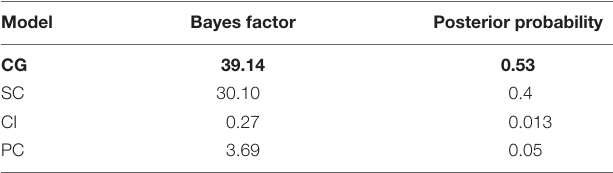
TABLE 3 | Bayes factor and posterior probability of the approximate Bayesian computation